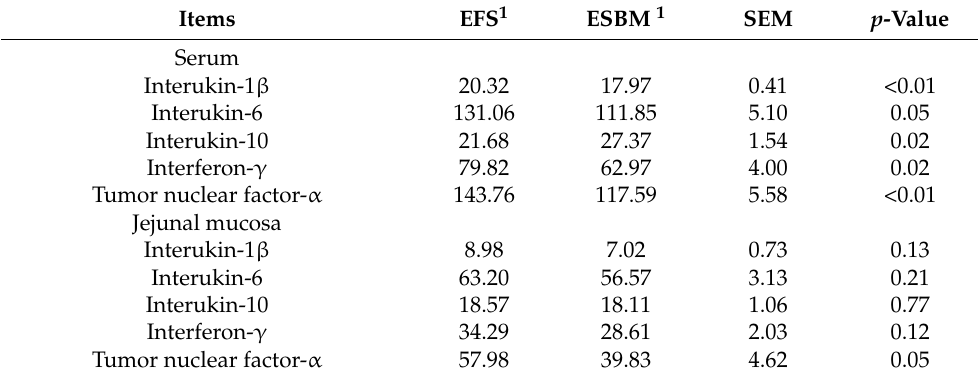
Table 4. Effects of enzyme-treated soybean meal replacing extruded full-fat soybean on interleukin cytokines in serum and jejunal mucosa of nursery pigs (pg/mg).